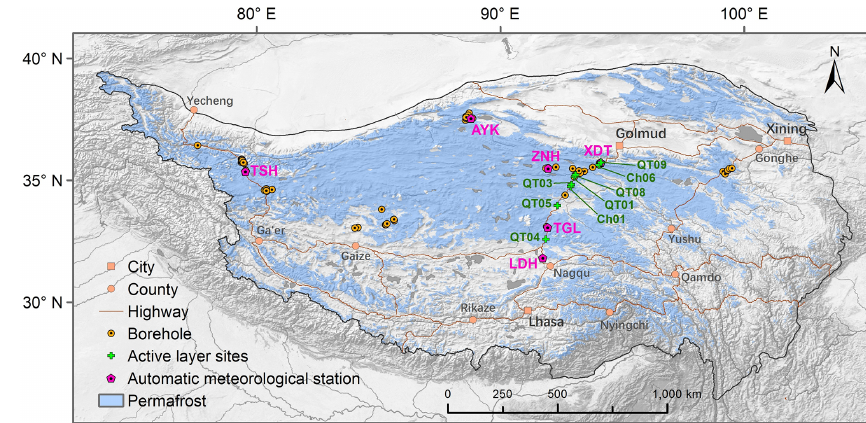
Figure 1. The permafrost monitoring networks on the QTP. AL: active layer; AWS: automatic meteorological station. Table 1. The observation instruments and items for meteorological data, ground temperature, and soil water content. Observation Available sites Observation site type